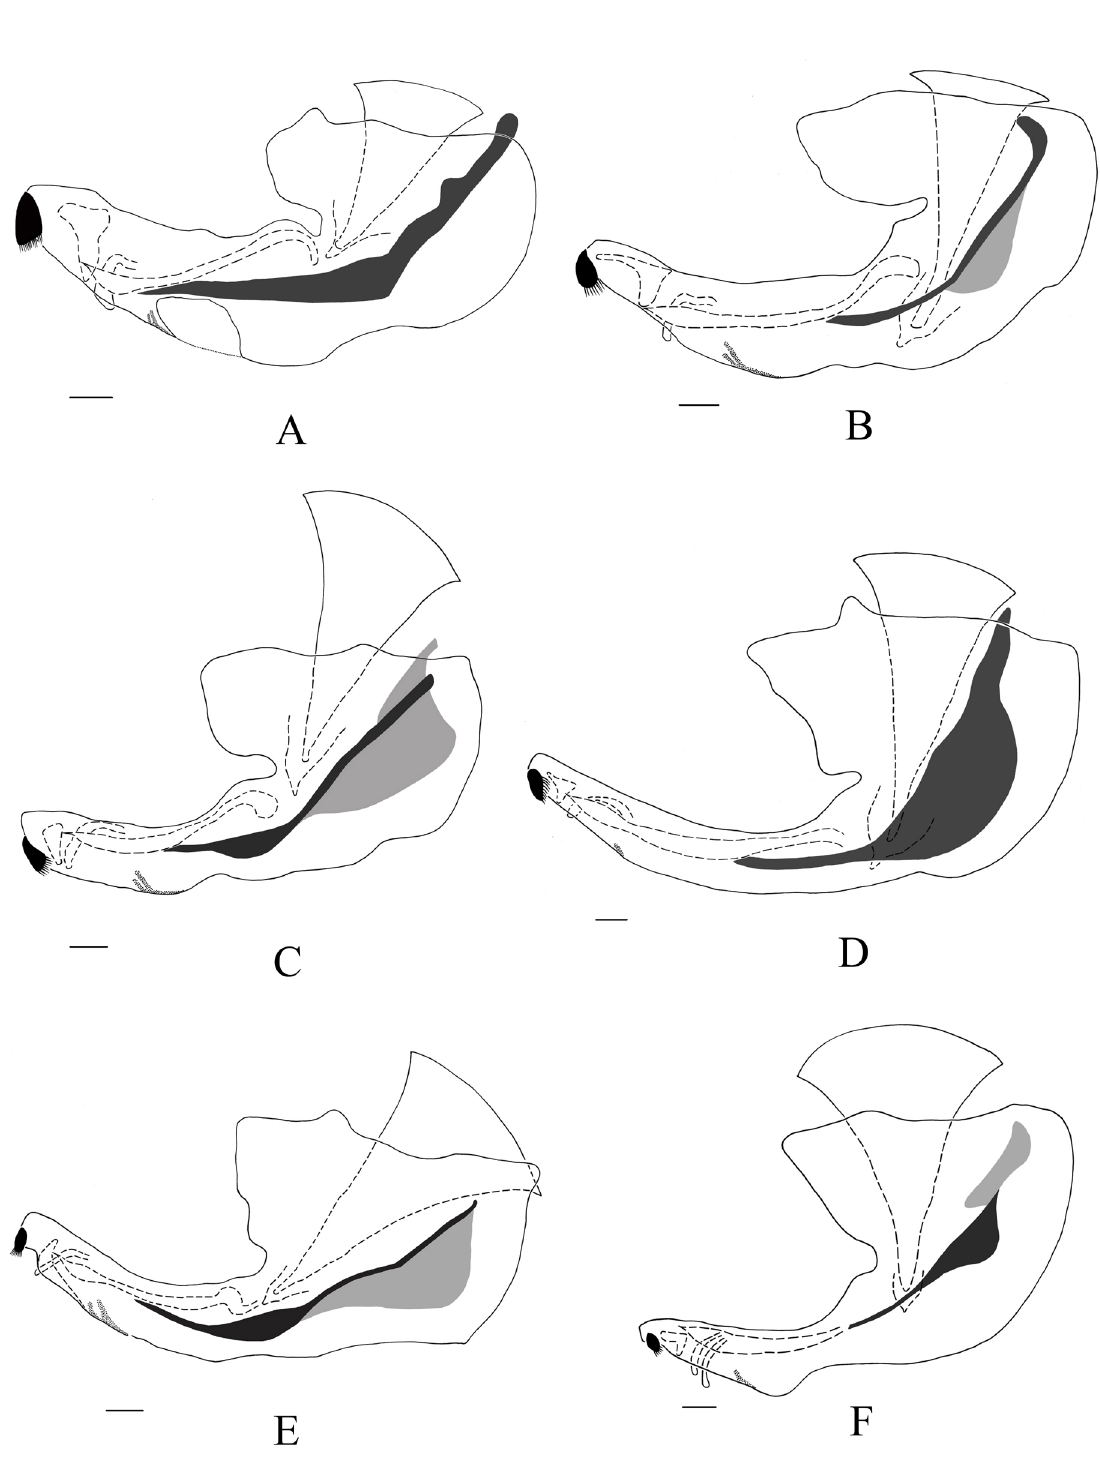
Fig. 22. Hypandrium, lateral view. A . Eumerus atricolorus Gilasian & van Steenis sp. nov., holotype (HMIM). B . E. brevipilosus Gilasian & van Steenis sp. nov., holotype (HMIM). C . E. chekabicus Gilasian & van Steenis sp. nov., holotype (HMIM). D . E. coeruleus (Becker, 1913), Chekab Valley, Iran (HMIM). E . E. ovoformus Gilasian & van Steenis sp. nov., holotype (HMIM). F . E. richteri Stackelberg, 1960, Lar, Iran (HMIM). Scale bars = 0.1